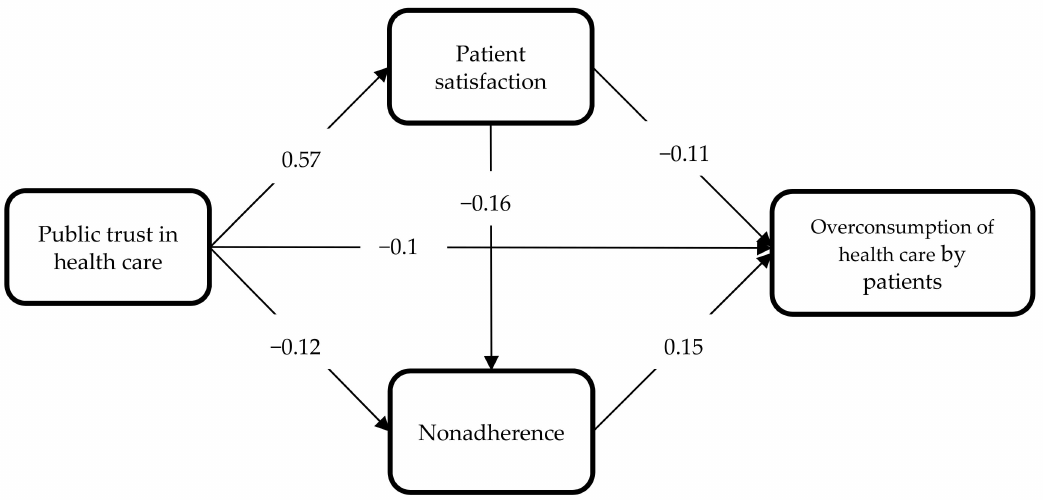
Figure 2. Model of relationship between public trust in health care and overconsumption of health care. Source: developed by the